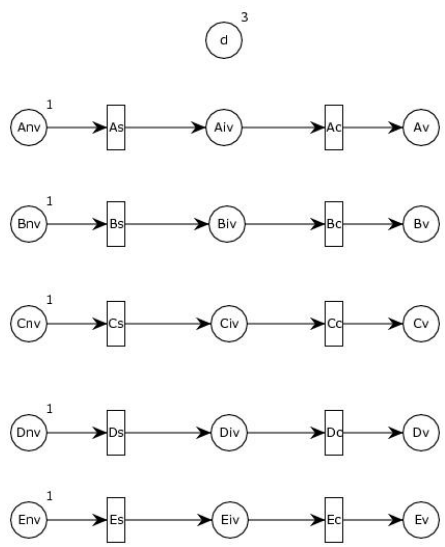
Figure 9. Depo with three salesmen and five cities.